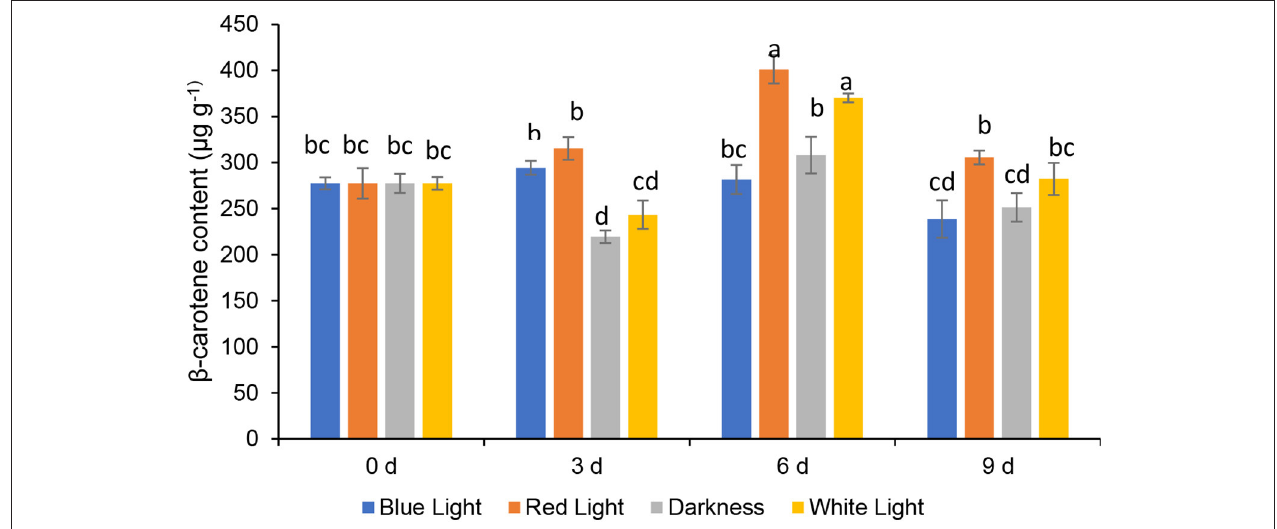
FIGURE 4 | Effect of blue and red LED light treatment on β - carotene content coriander ( Coriandrum sativum ) leaves. Different letters in the same bar indicate significant differences at p < 0.05.